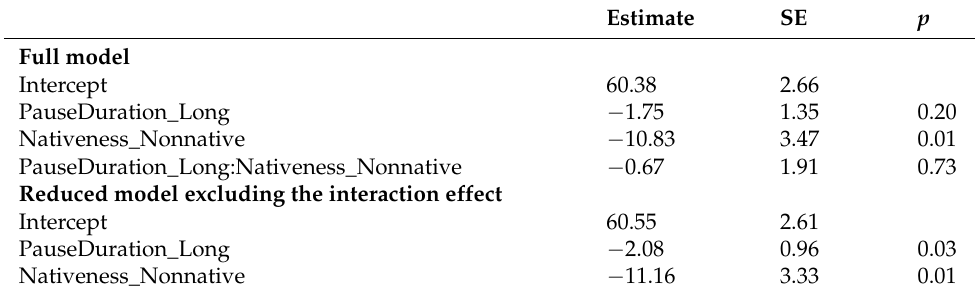
Table 1. Results of the linear mixed model exploring the effects of pause duration and nativeness on perceived knowledge. The table reports estimated model coefficients (Estimate), standard errors (SE) and p -values ( p ). Because of the non-significant interaction effect in the full model, to determine the effects of pause duration and nativeness alone, we also report the results of a reduced model excluding this interaction